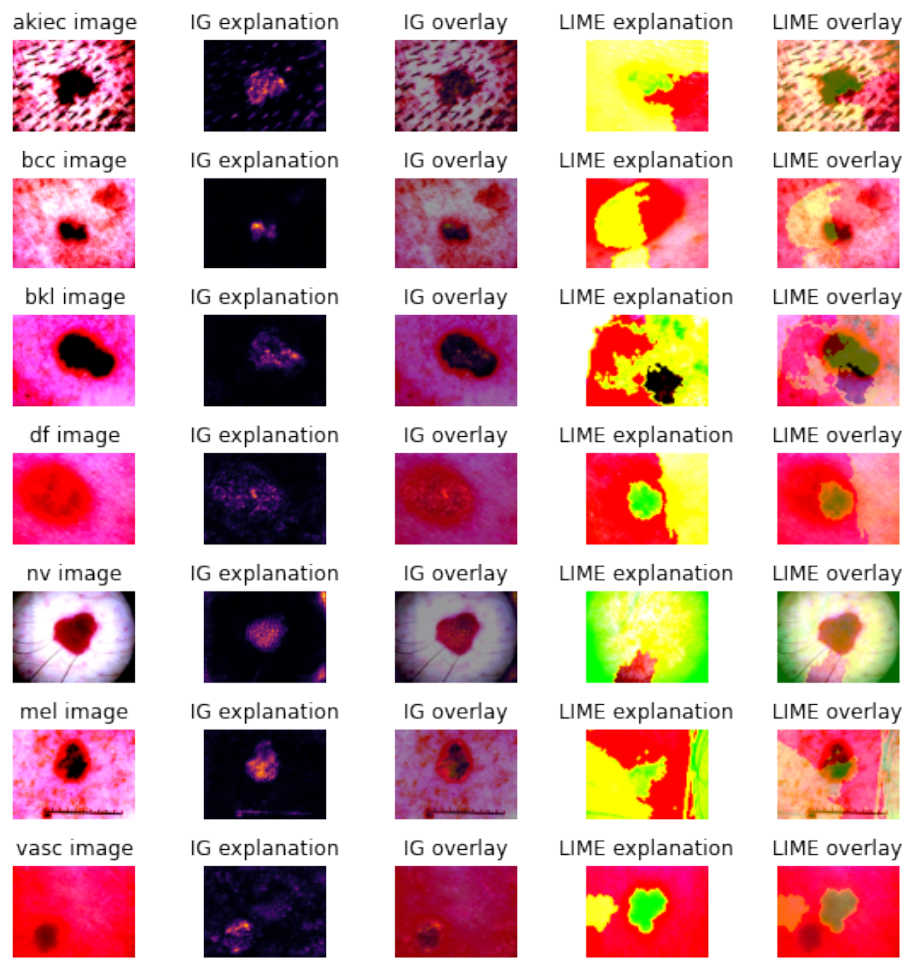
Figure 5. Attribution maps/visual explanation of the explanation techniques for those images in the test set that the classifier misclassified with the highest probability. From left to right: original preprocessed image of the class that the classifier misclassified with the highest probability, integrated gradient explanation, integrated gradient explanation overlayed on the misclassified image, LIME explanation, LIME explanation overlayed on the misclassified